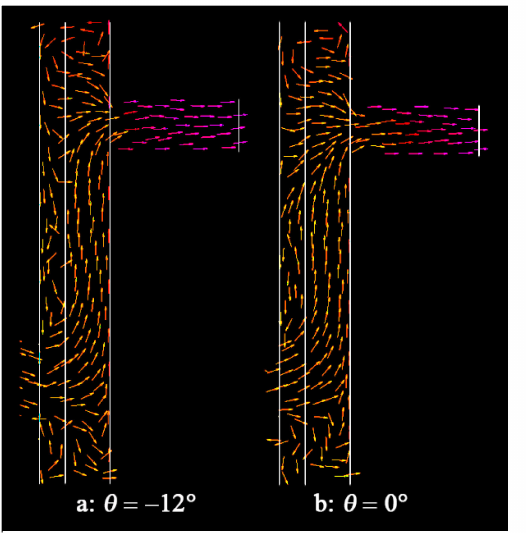
Figure 14. Streamlines at the r - z plane for ξ = 1.225: ( a ) θ = − 12 ◦ , ( b ) θ = − 0 ◦